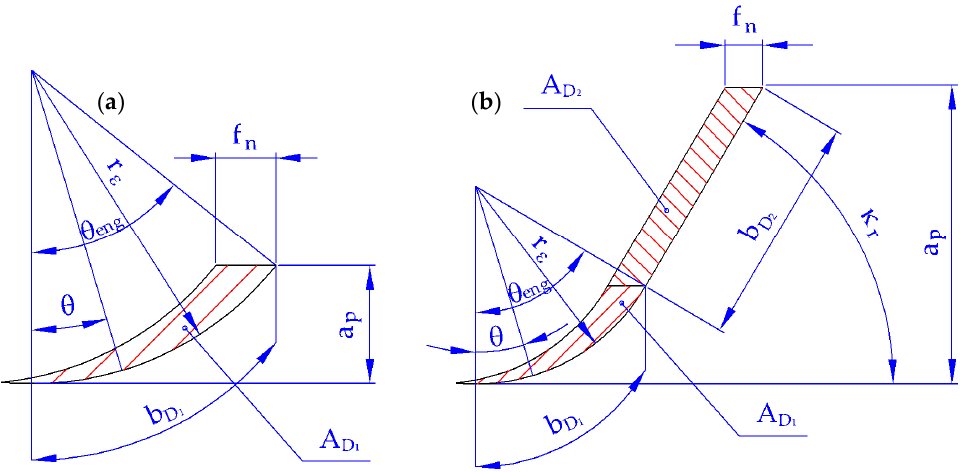
Figure 2. Cutting area when cutting: ( a ) with the rounded part of the cutting edge; ( b ) with the rounded as well as the straight part of the cutting edge.